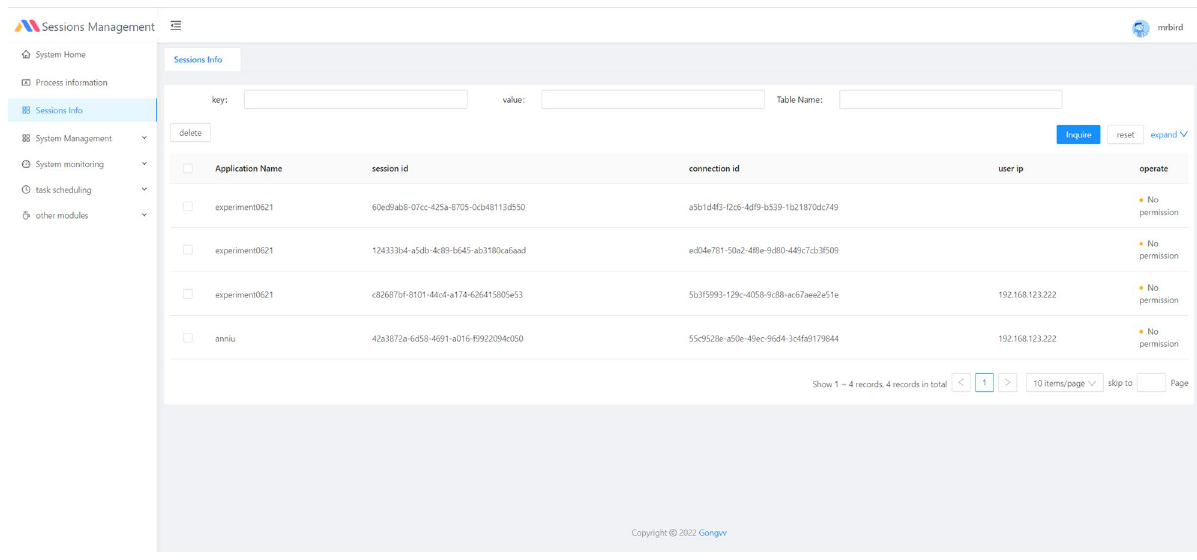
Figure 2. Session information in the session manager.